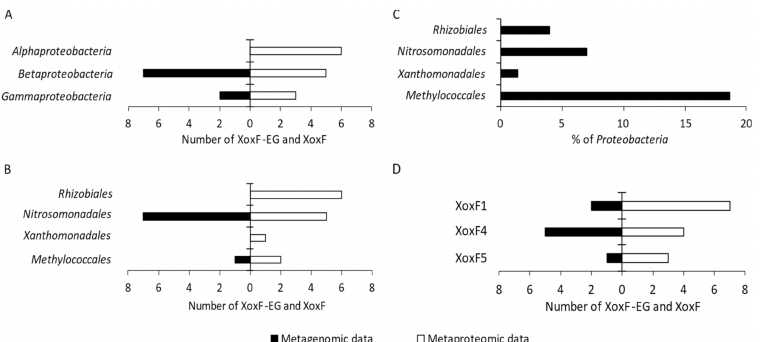
Figure 3. The number of XoxF-EG and XoxF enzymes detected in the proteobacterial metagenome and metaproteome among classes ( A ) and orders ( B ). Percentage distribution of bacterial orders with XoxF ( C ); number of the identified XoxF clades within Proteobacteria ( D ).